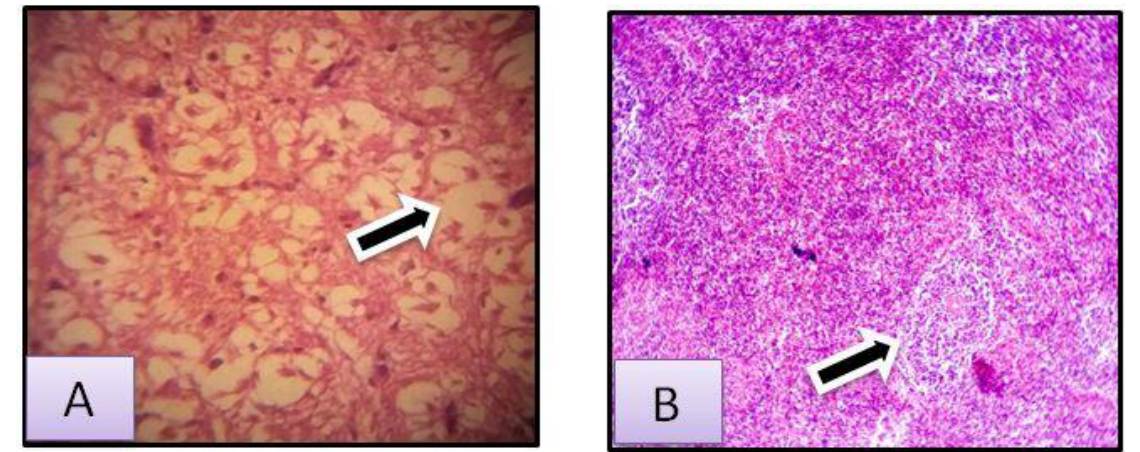
Fig.9: A: brain section showed spongy form (neurophagia) due to death and lyses of the neuron black arrow X 40, while B: showed spleen section with depletion (back arrow) of white pulp and proliferation X